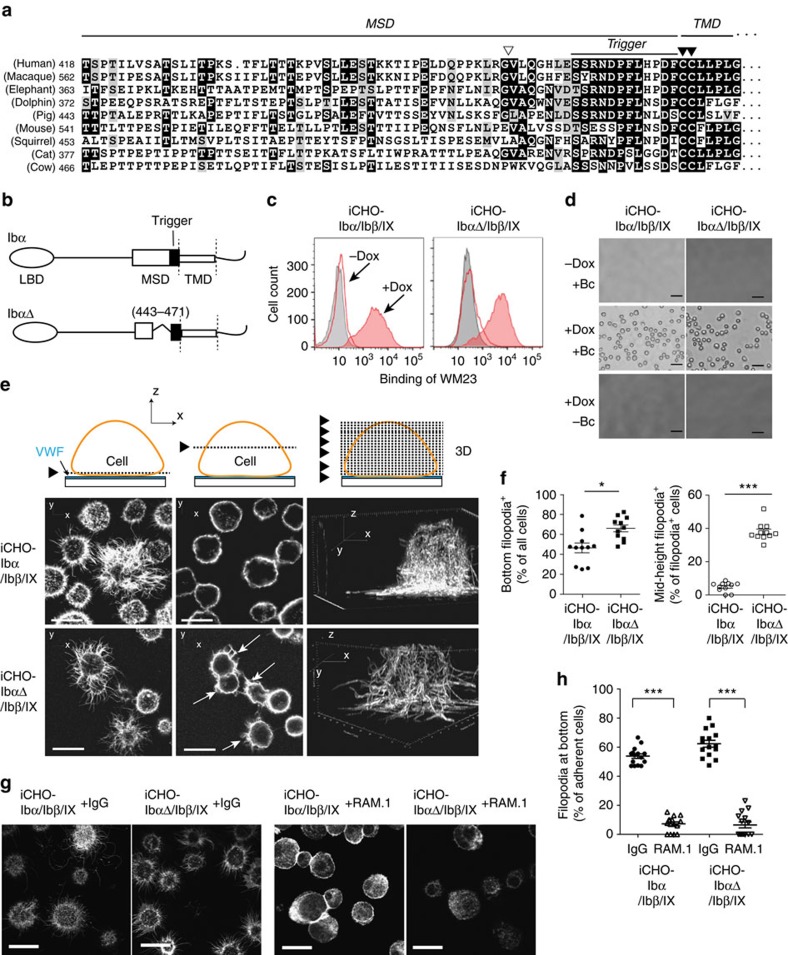
A deletion mutation unfolding the MSD causes ligand-free GPIb–IX signalling.(a) Sequence alignment of the MSD from selected species. Sequences are obtained from the Ensembl Genome Database. The alignment is anchored at the conserved vicinal cysteine residues marked by filled triangles. Highly and weakly conserved residues are shaded black and grey with BOXSHADE program, respectively. The ADAM17 cleavage site is marked by an open triangle. (b) Schemes of MSD-unfolding mutant GPIbαΔ and wild-type GPIbα. In GPIbαΔ, residues 443–471 in the MSD were deleted. The Trigger sequence in MSD is coloured black. (c) Flow histograms of GPIbα on inducible CHO cells that expressed wild-type (iCHO–Ibα/Ibβ/IX) or mutant (iCHO-IbαΔ/Ibβ/IX) complex. Grey filled: untransfected cells; red open: transfected cells without doxycycline induction (−Dox); red filled: transfected cells after doxycycline induction (+Dox). (d) Microscopic images showing that transfected cells adhered to the VWF surface only on doxycycline induction and in the presence of botrocetin (Bc). Scale bar, 40 μm. (e) GPIbαΔ, but not wild type, induced ligand-free filopodia formation in transfected cells. Top row: cartoons of cell and VWF-coated slide, with triangles marking the z position of the viewing panel(s) at: (left) near bottom, in proximity with coated VWF; (middle) middle of the cell, where VWF was absent; and (right) three-dimensional reconstruction of a representative cell. Middle row: images of iCHO–Ibα/Ibβ/IX cells. Bottom row: iCHO–IbαΔ/Ibβ/IX cells; white arrowheads mark the filopodia extrusion in the absence of VWF. Scale bar, 10 μm. (f) Quantificative comparison of filopodia formation at the bottom (left) and in the middle (right) of adherent cells. Cells with >3 filopodia of >2-μm length were considered positive. A total of 200 cells from 11 view fields were visually examined and counted. Data are shown as mean±s.d. from three independent experiments. *P<0.05; ***P<0.001. (g) Representative images (bottom view) showing that RAM.1, not rat IgG, inhibits the filopodia of iCHO–Ibα/Ibβ/IX and iCHO–IbαΔ/Ibβ/IX cells. (h) Quantificative comparison of filopodia of IgG- and RAM.1-treated cells. The cells from 15 view fields were visually examined and counted. Data are shown as mean±s.d. from three independent experiments. ***P<0.001.